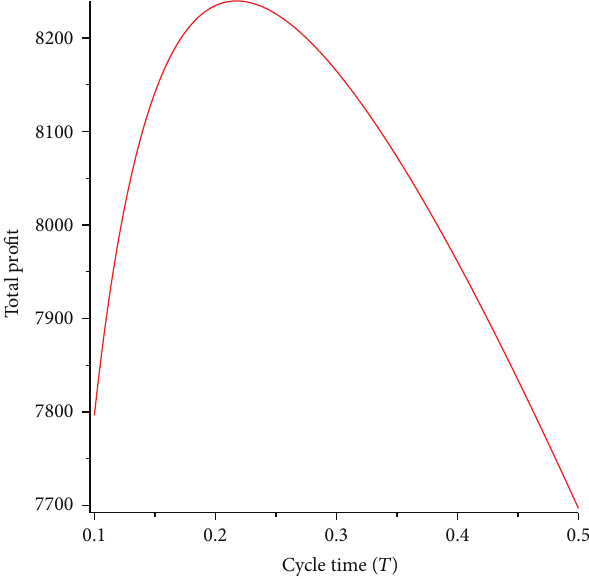
Figure 1: Concavity of total profit with respect to cycle time 𝑇 for 𝑀 ≥ 𝑇 + 𝑁